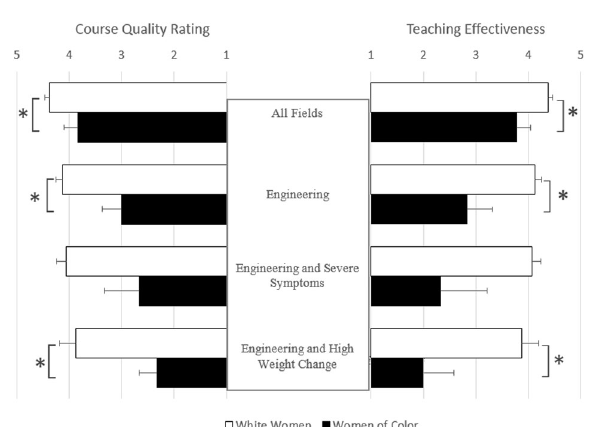
Fig. 3 The mean rating scores as reported by faculty of course quality and instructor effectiveness during pregnancy for white women and women of colour for all fi elds, for women in engineering, for women in engineering with severe symptoms, and for women in engineering with a high (over 30 pounds) weight change. Being in engineering causes women ’ s scores to drop. Compounding being in engineering with severe symptoms or a high weight change causes a greater drop in evaluations for all women. This drop is larger for women of colour. Error bars show standard error and asterisks indicate statistical signi fi cance ( p <